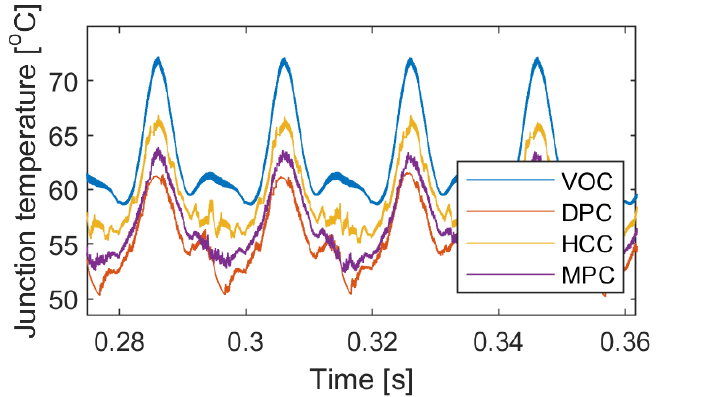
Figure 34. MOSFET Junction temperature variation under different control